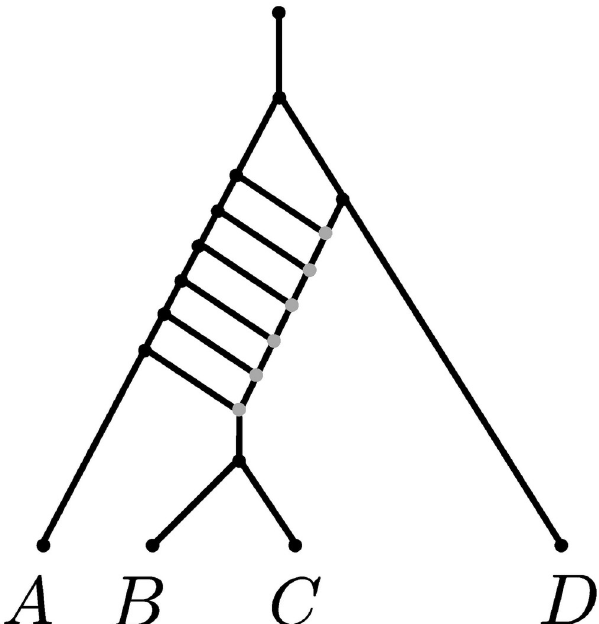
Fig 6. Example of a phylogenetic network where the level ℓ is equal to 6 (the reticulation nodes are depicted in grey), while K 2 f 3 ; 4 ; 5 ; 6 ; 7 g , depending on the traversal algorithm (not shown). A traversal ensuring that K remains close to the lower end of this interval (the scanwidth of the network [66]) will be several orders of magnitude faster than algorithms whose complexity depends exponentially on ℓ . Increasing the number of reticulation nodes while keeping a “ladder” topology as above can make ℓ arbitrarily large, while the scanwidth remains constant. This topology may seem odd but it is intended as the backbone of a more complex and realistic network with subtrees hanging from the different internal branches of the ladder, in which case the complexity issue remains.